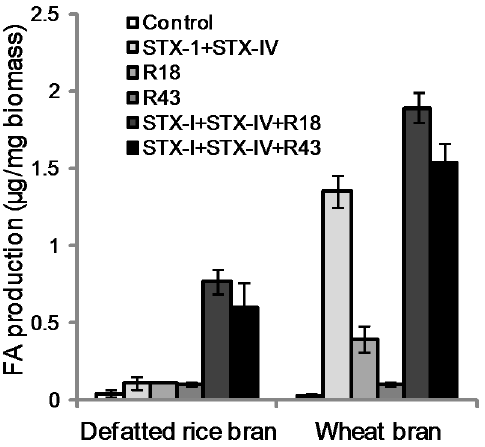
Figure 5. FA production from biomass by Streptomyces FAEs. Bars indicate the averages of three independent experiments. Error bars represent standard deviations.